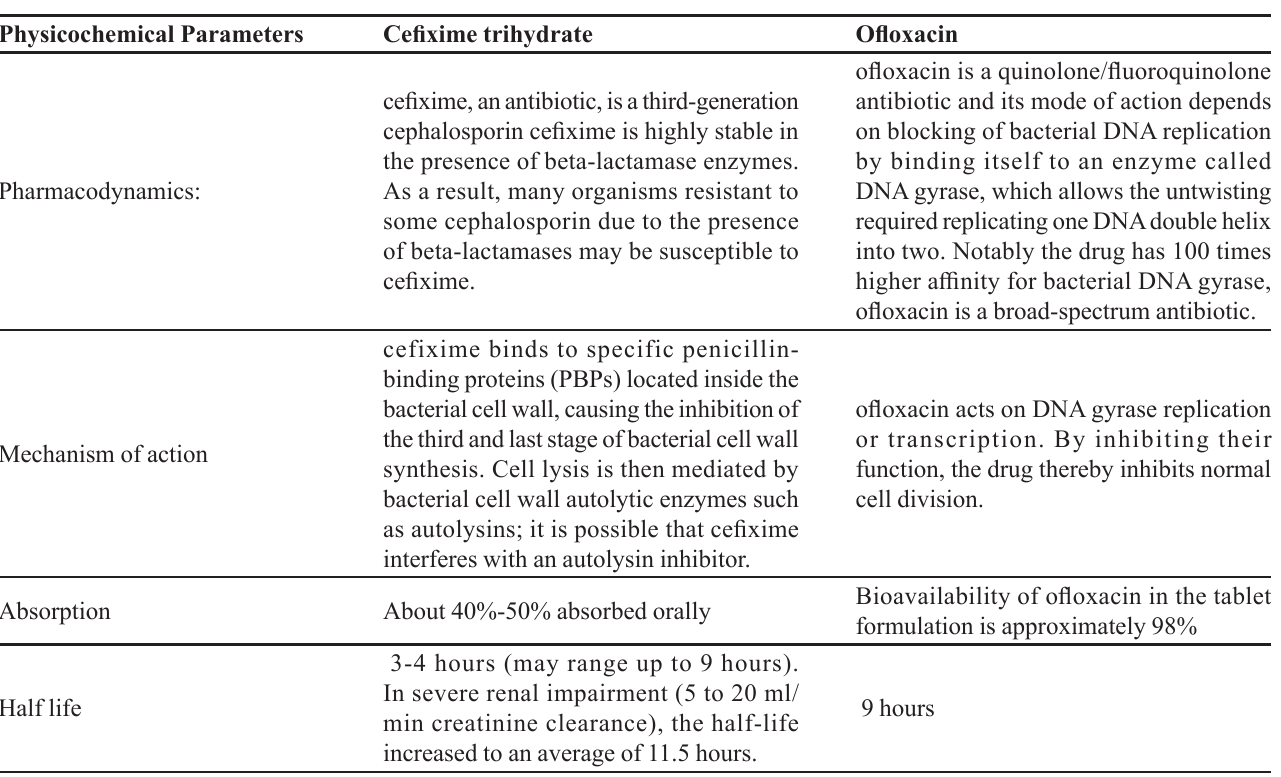
TABLE I - Physicochemical parameters of cefixime trihydrate and ofloxacin Physicochemical Parameters Cefixime trihydrate